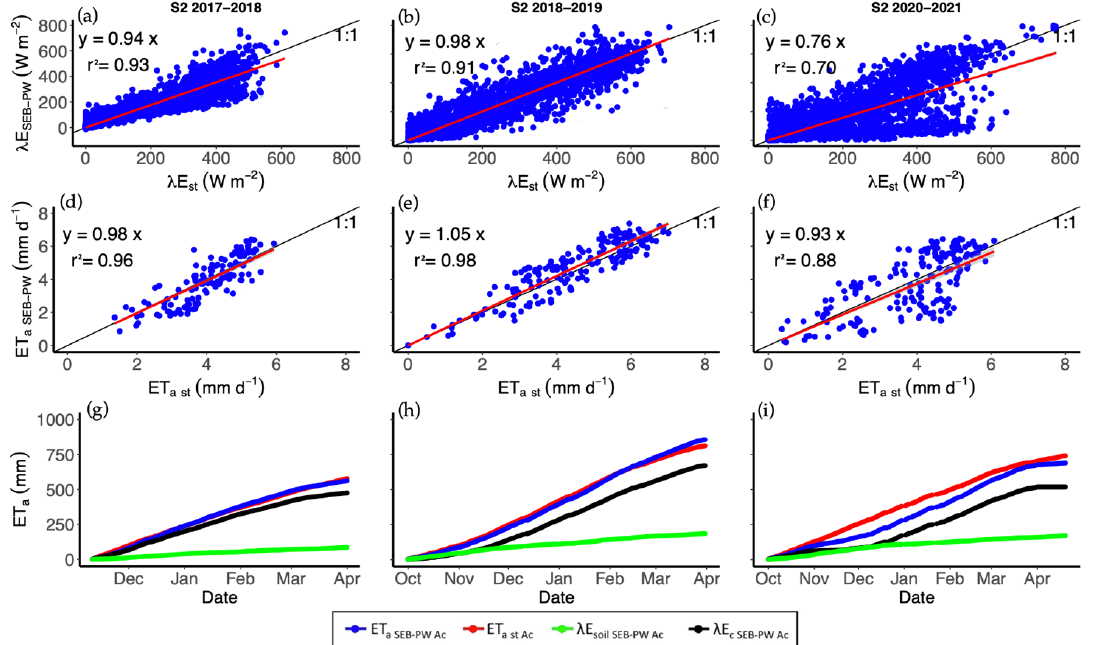
Figure 14. Relationships between modeled (SEB – PW) and measured (ST) hourly λE ( a – c ) and daily ET ( d – f ), and cumulative actual ET (ETa SEB – PW , and ETa st ), soil E (λE soil SEB – PW ), and crop T (λEc SEB – PW